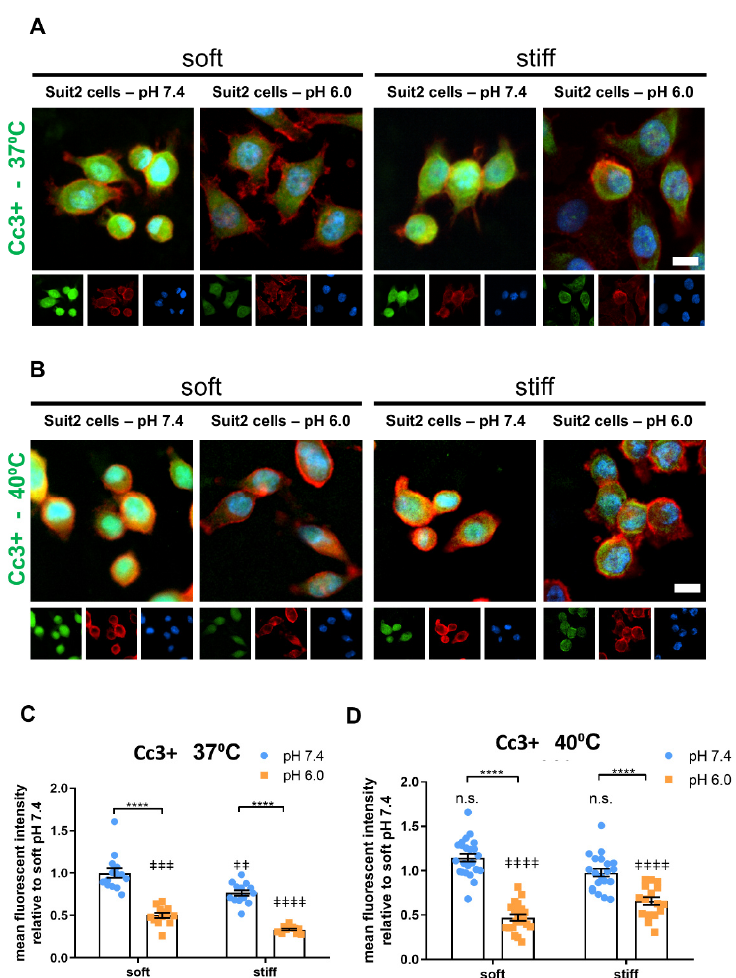
Figure 4. Apoptosis of Suit-2 007 cells is decreased as a result of tumor pH (6.0) and higher stiffness. ( A , B ) Widefield, epifluorescent images of Cc3+ (Cleaved caspase 3) as a marker of apoptosis, for cells cultured on soft (Gamma 2) and stiff (Alpha 2) Manchester BIOGEL PeptiGels in physiologi- cally healthy (7.4) and tumor-mimicking (6.0) pH at 37 °C ( A ) and 40 °C ( B ). Cc3+ (green), actin (red) and nucleus (blue). Scale bar represents 50 µm. ( C , D ) MFI-mean fluorescence intensity (expressed in arbitrary units) of Cc3+ stained cells presented in ( A , B ), respectively. Histogram bars represent the mean ± SEM, and dots represent the average Cc3+ intensity within a sample (20 cells measured per sample) across three experimental replicates. * markers denote a significant difference between bracket-marked groups by t -test, **** p < 0.0001. ‡ markers denote a significant difference from